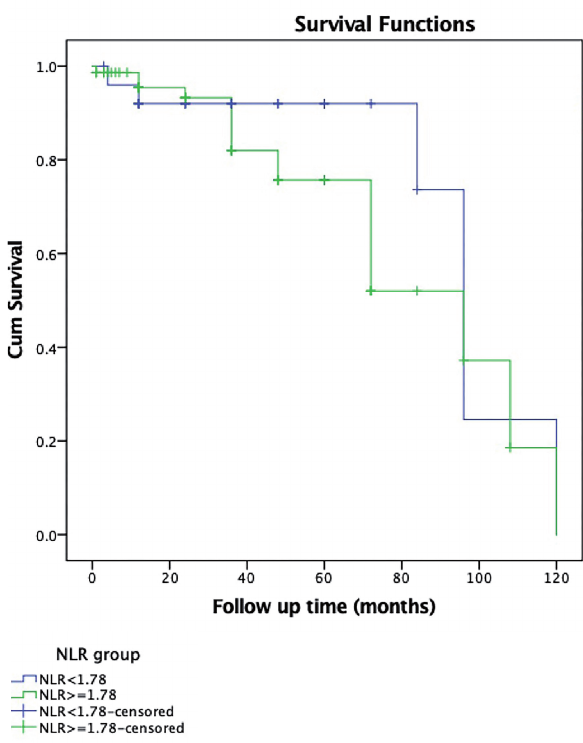
Figure 2 - Kaplan-Meier curves used to evaluate the correlation between neutrophil-to lymphocyte ratio and